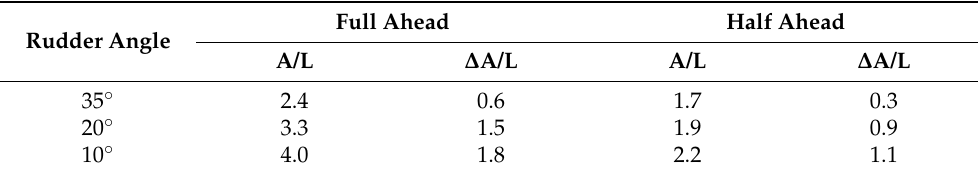
Table 9. Nondimensional advance in turning circle trial for engine setting Full Ahead and Half Ahead, rudder angles set to starboard, and clockwise direction of RC2 rotational speeds RPM.